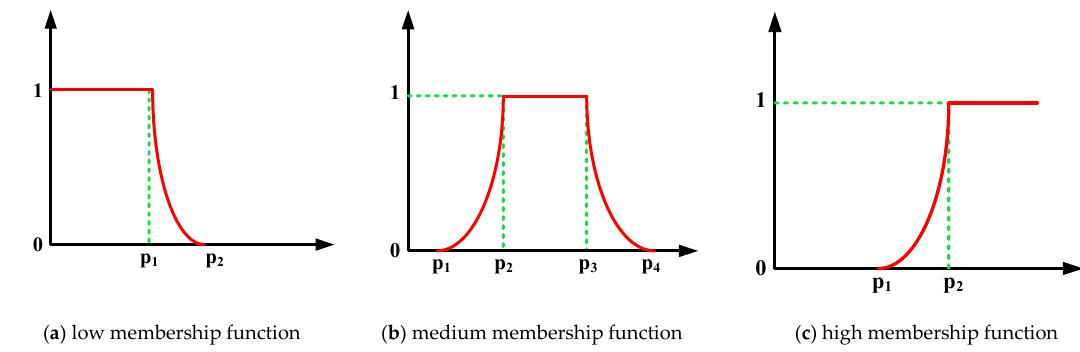
Figure A1. Three different levels of membership functions for the CMFI system. Figure A1. Three di ff erent levels of membership functions for the CMFI